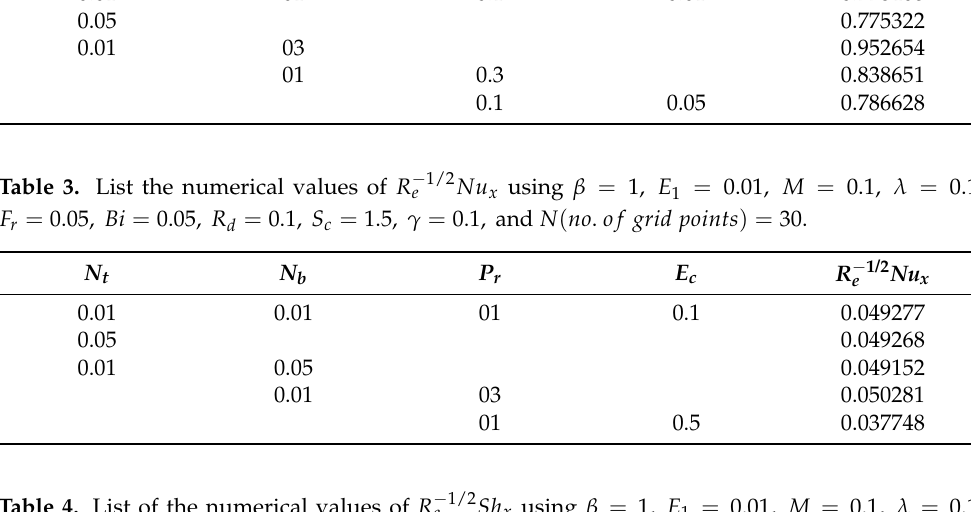
Table 4. List of the numerical values of R − 1/2